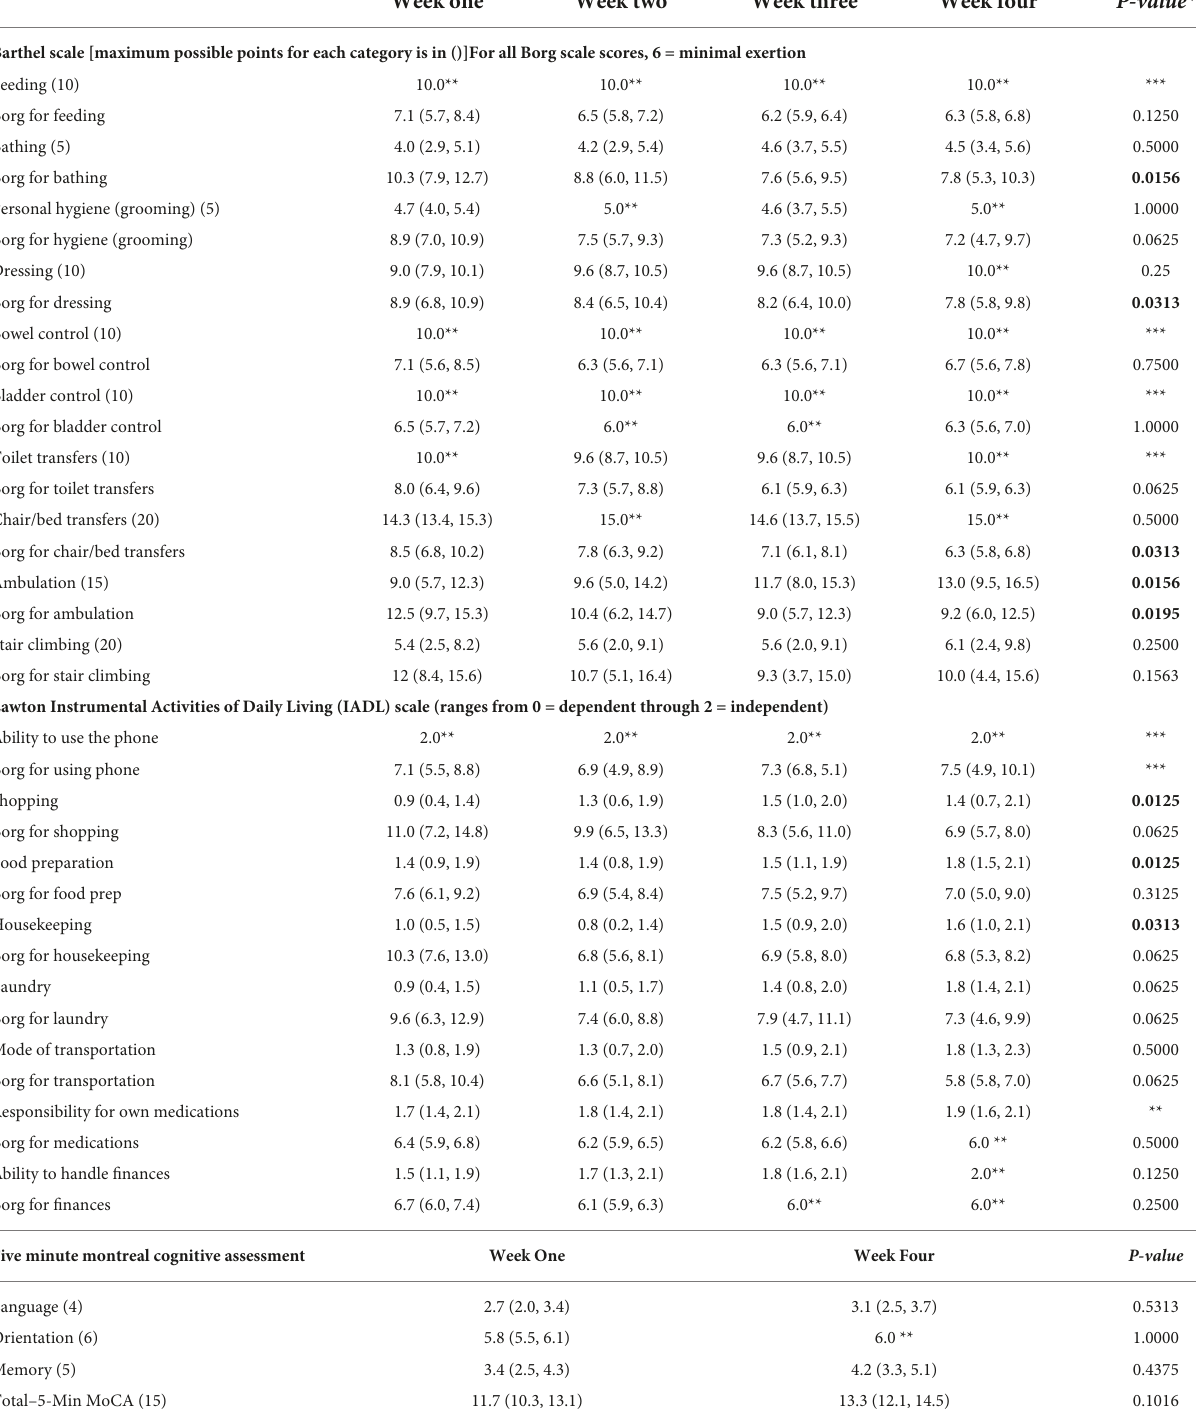
TABLE 3 Occupational therapy data. Week one Week two Week three Week four P-value * Barthel scale [maximum possible points for each category is in ()]For all Borg scale scores, 6 = minimal exertion Feeding